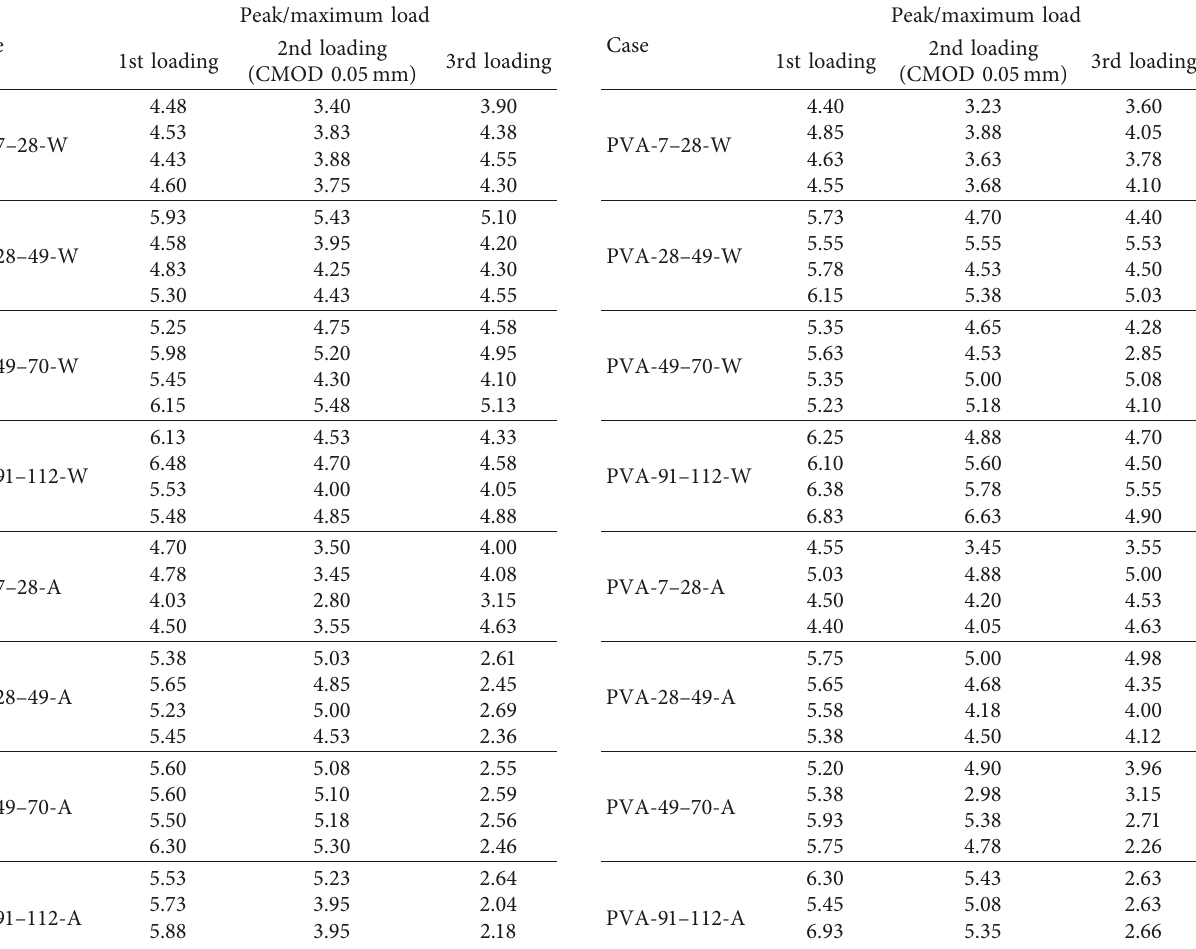
Table 6: Peak and maximum load of PE concrete. Table 7: Peak and maximum load of PVA